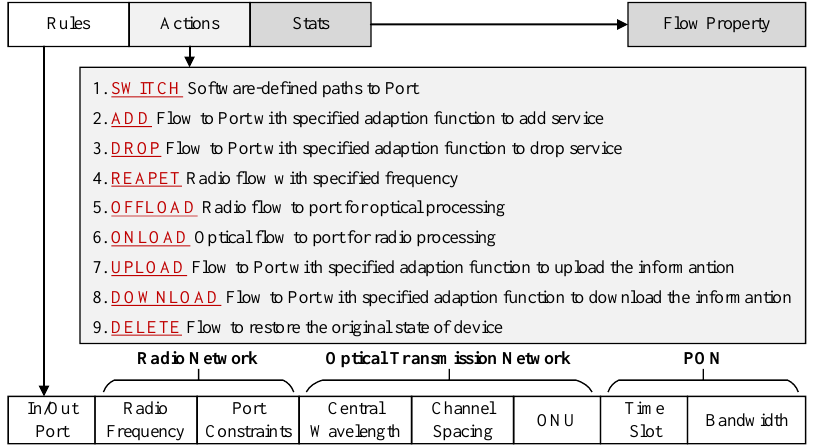
Figure 4. Enhanced OpenFlow protocol in enhanced OpenFlow